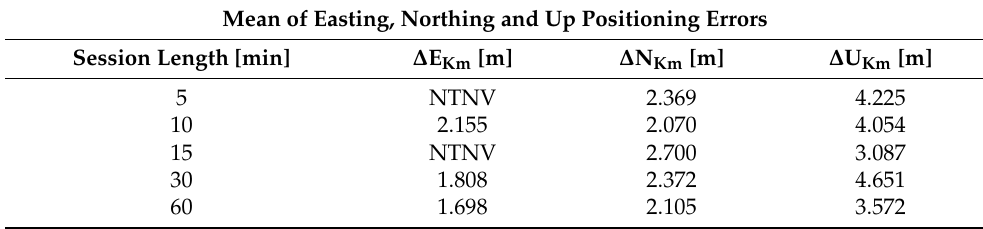
Table 9. Mean of Easting, Northing and Up DGNSS positioning errors for ∆ E Km , ∆ N Km , ∆ U Km .